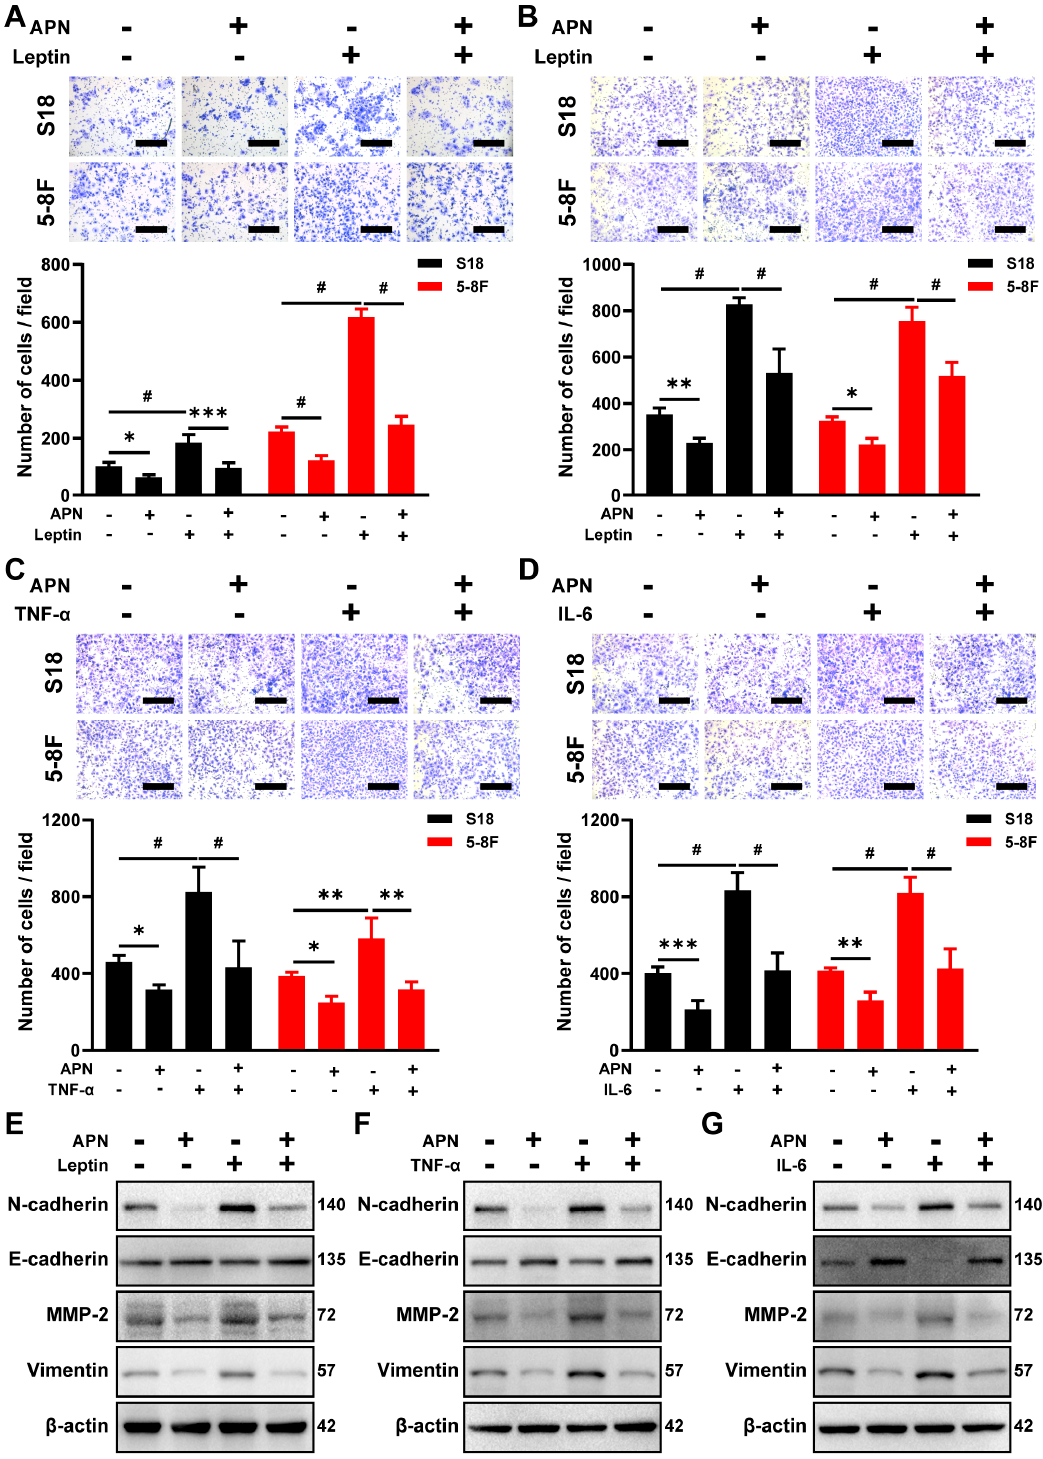
Figure 3. Adiponectin blocks leptin, IL-6, or TNF- α -induced NPC cell invasion and migration. Transwell migration ( A ) and invasion ( B ) assays in S18 and 5-8F cells pretreated with 40 μ g/mL adiponectin for 2 h before treatment with 50 ng/mL leptin. Scale bar: 200 μ m. Graphs show the relative number of cells. Transwell migration assay in S18 and 5-8F cells pretreated with 40 μ g/mL adiponectin for 2 h before treatment with 50 ng/mL TNF- α ( C ) or 50 ng/mL IL-6 ( D ). Scale bar: 200 μ m. Graphs show the relative number of migration cells. ( E – G ) Western blot analysis of E-cadherin, N-cadherin, MMP-2, and Vimentin in 5-8F cells pretreated with 40 μ g/mL adiponectin in the presence or absence of leptin (50 ng/mL), TNF- α (50 ng/mL), or IL-6 (50 ng/mL) for 48 h. Results are